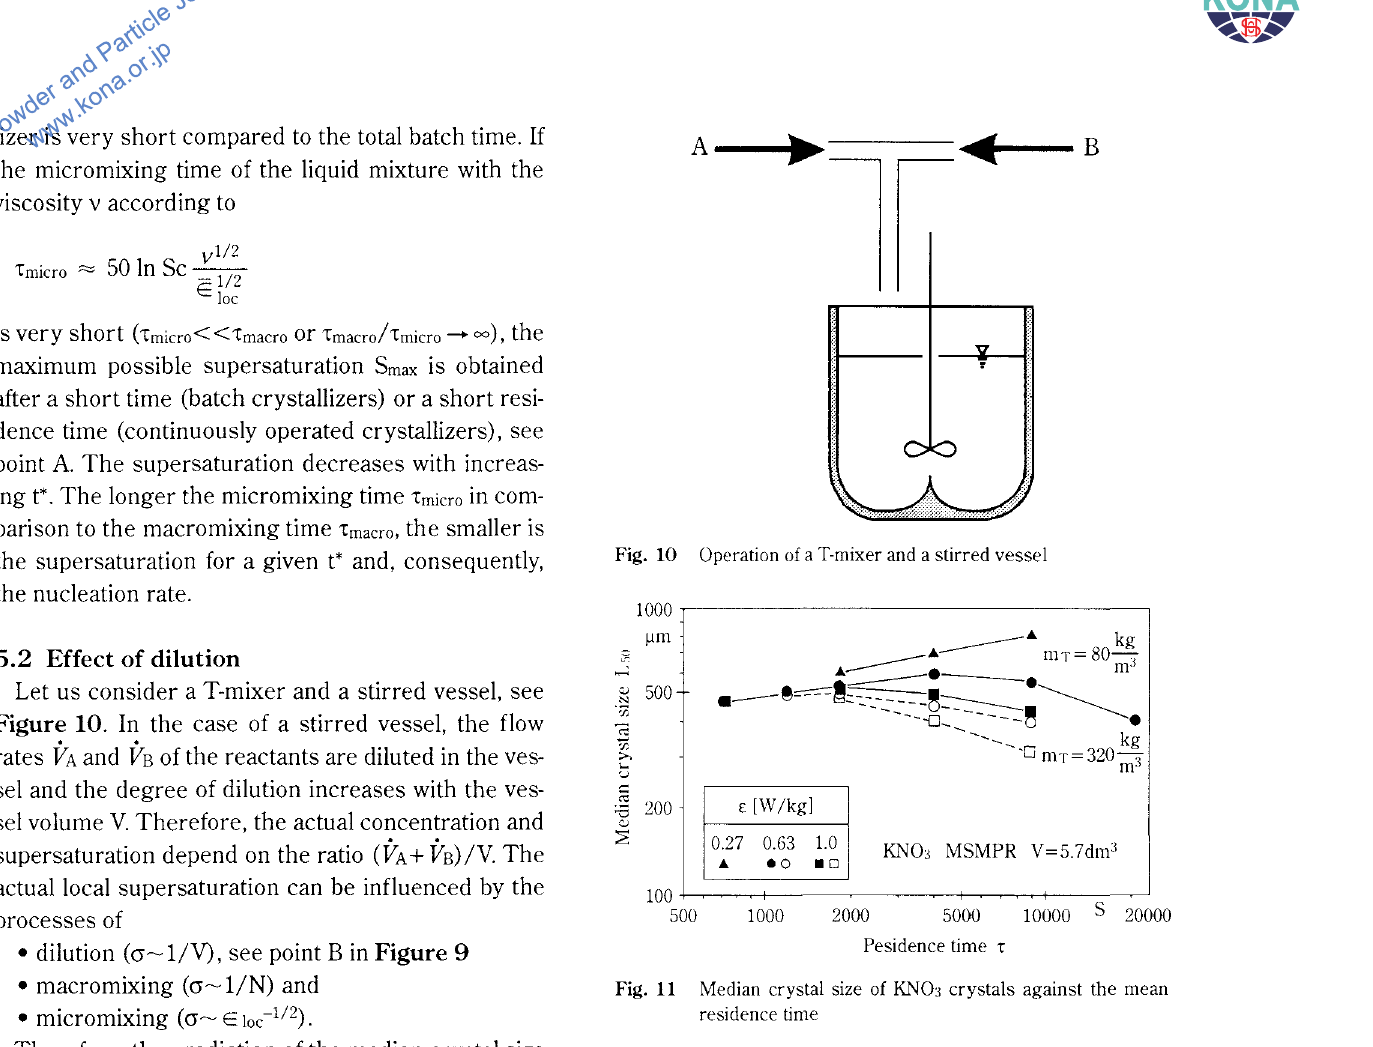
trolled by attrition, see Figure 11. In this